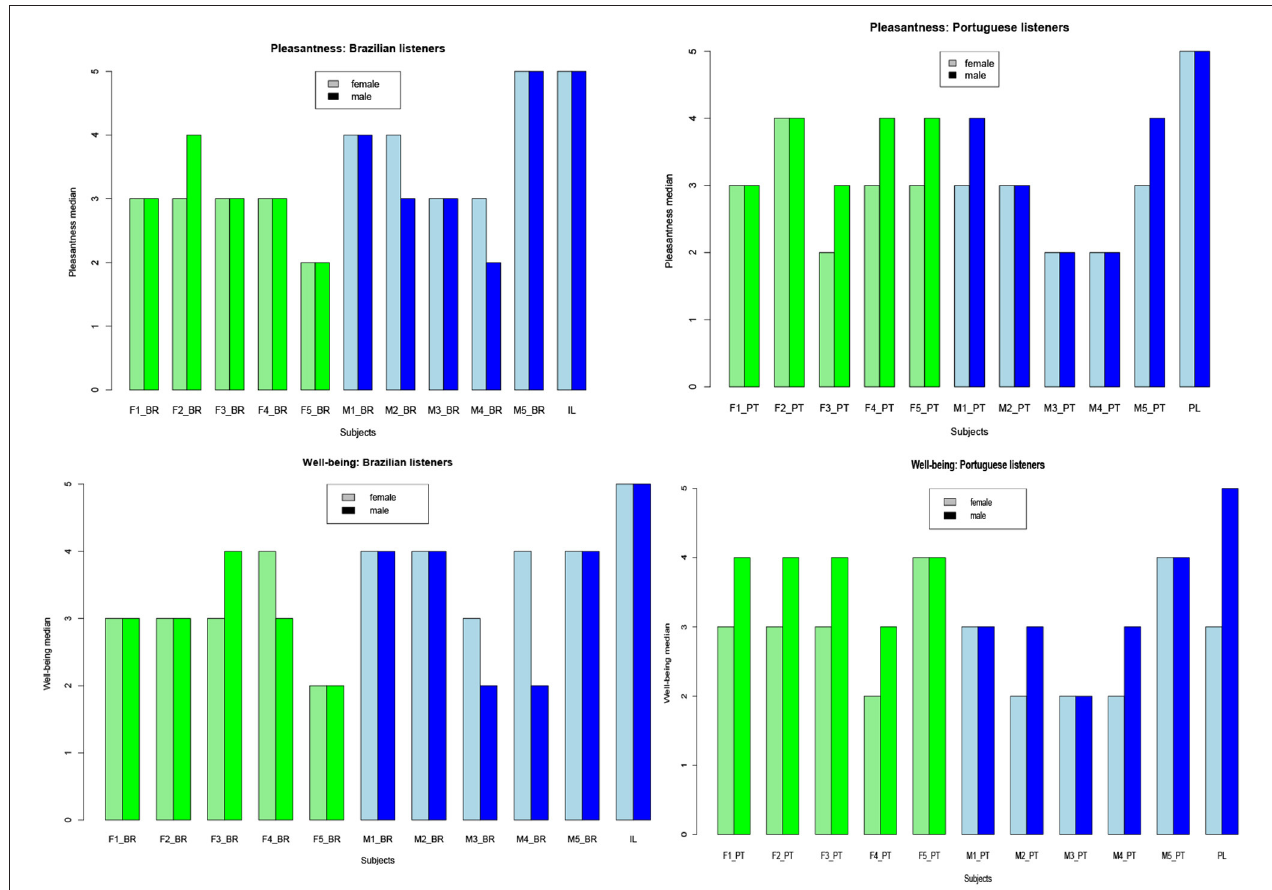
FIGURE 1 | Medians of degrees attributed when Brazilian (left) and Portuguese (right) listeners evaluated the pleasantness (top) and the wellbeing (bottom) of the whole poem. The gender of the reciter is indicated (Mn signals a male reciter, Fn signals a female reciter n). IL is the Brazilian actor and PL the Portuguese actor. The gender of the listener is indicated by the darkness of the color (the darker bar to the right in the contiguous bars are from male